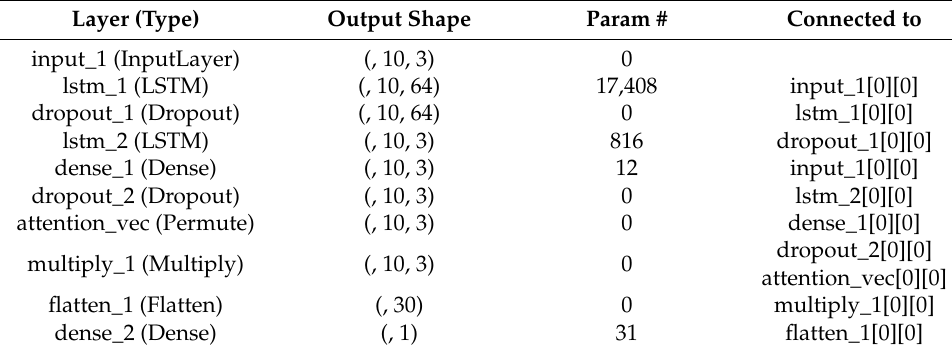
Figure 11. Schematic diagram of multi-layer LSTM model. Table 1. Node parameter table of the neural network model.